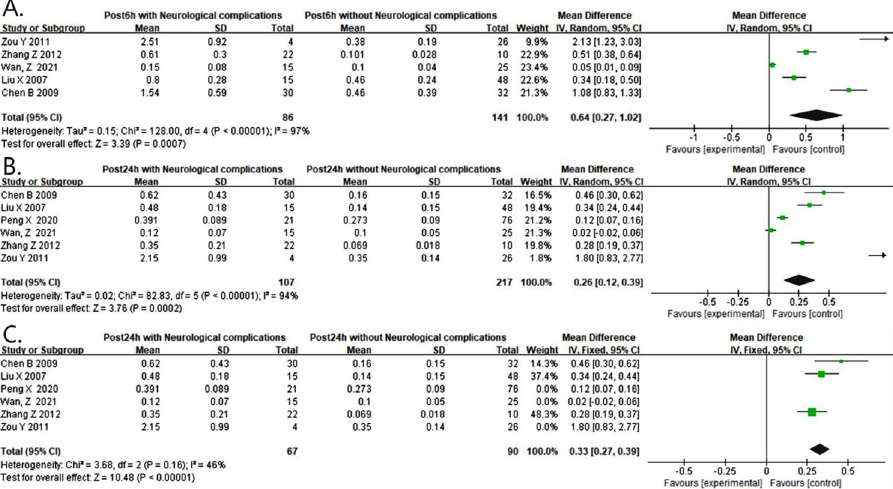
Fig 3. (A) Forest plot of S100B predicting neurological complications at 6 hours after operation. (B) Forest plot of S100B predicting neurological complications at 24 hours after operation. (C) Forest plot of the pooled result after corrected by the sensitivity